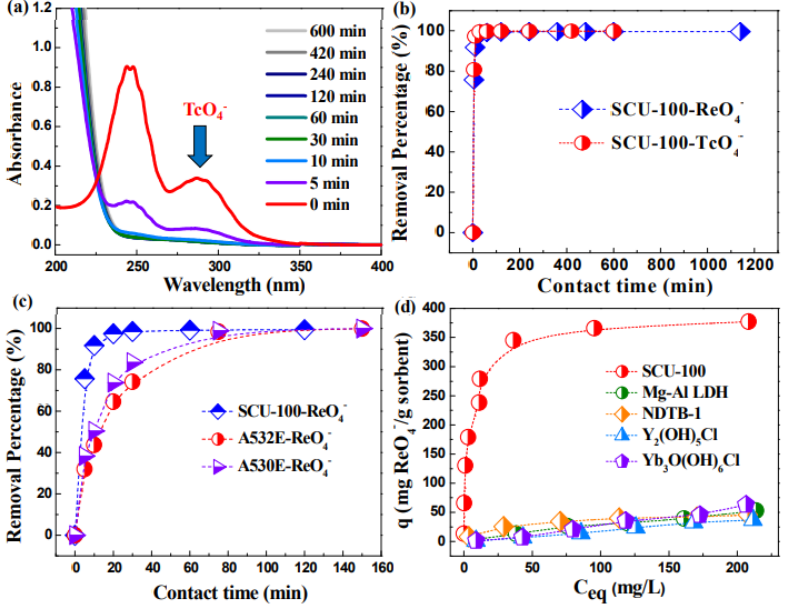
Figure 9. ( a ) UV-vis absorption spectra of aqueous TcO 4- solution during the anion exchange with SCU-100, ( b ) Removal percentage of TcO 4- and ReO 4- by SCU-100 as a function of contact time, ( c ) Comparison of the sorption kinetics of ReO 4- by SCU-100, A532E, and A530E, ( d ) Sorption isotherms of ReO 4- by cationic SCU-100 compared with other materials [60], Copyright 2017 American Chemical Society.